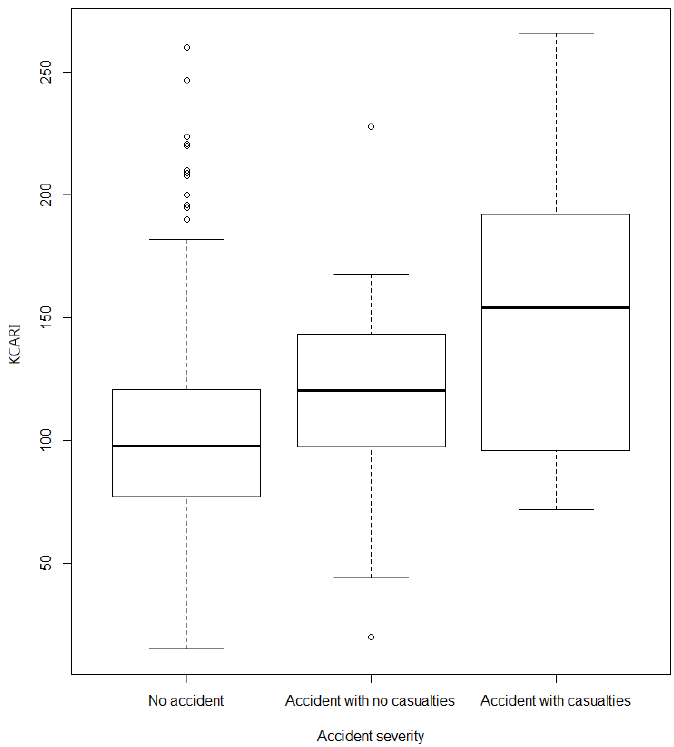
Figure 2. The average KCARI values by accident severity category.